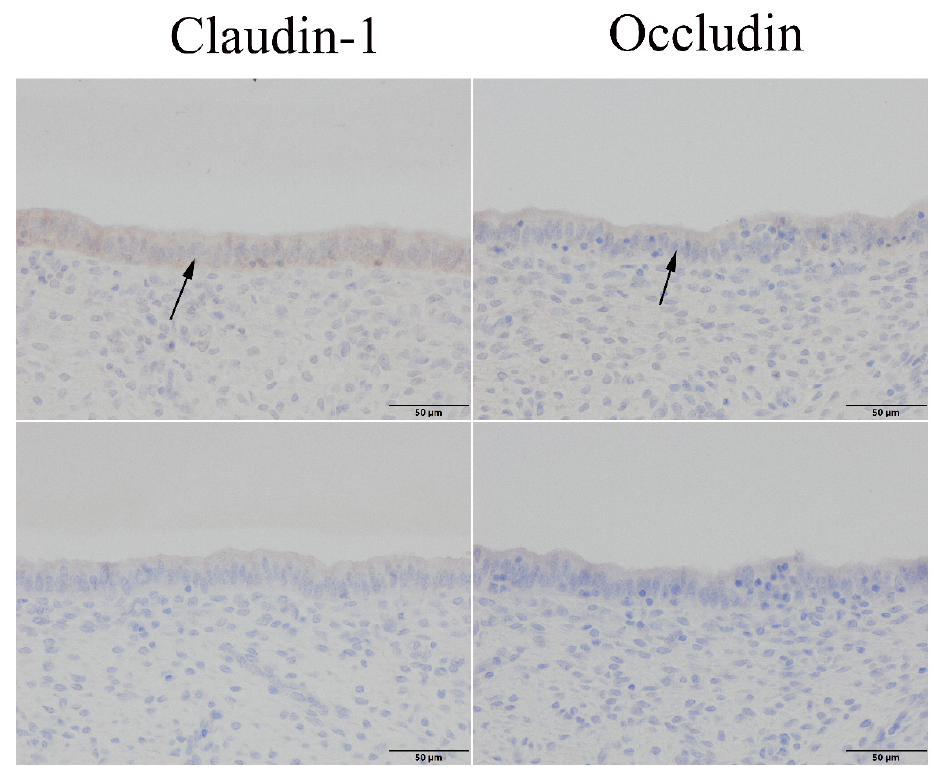
Figure 3. Immunohistochemical staining of claudin-1 and occludin in sheep uterine tissue samples. The arrows show the endometrial epithelium. Original magnification 400×. The superstratum is positive for claudin-1 and occludin, while the lower layer is the negative control of the same part.